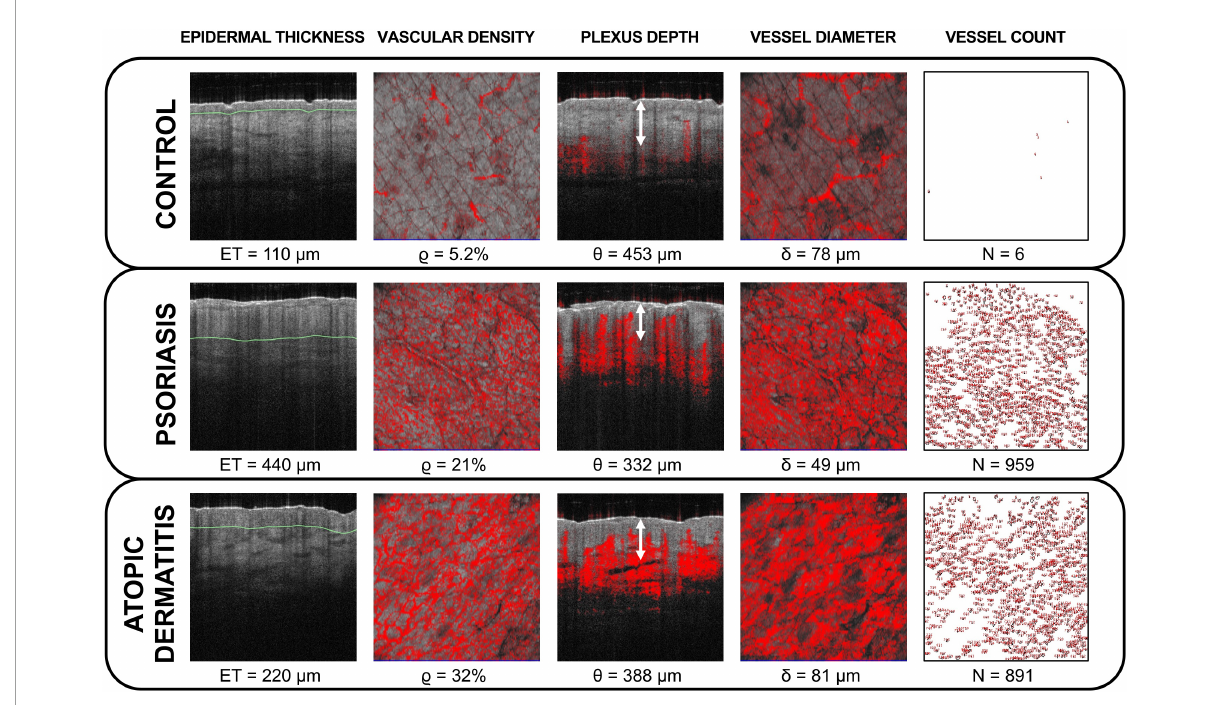
FIGURE2 Optical coherence tomography (OCT) imaging parameters for objective quantification of skin inflammation. Epidermal thickness ( ET ), vascular density (cid:37) , plexus depth θ , vessel diameter δ , and vessel count N were calculated in unaffected skin (control) and in target lesions (psoriasis and atopic dermatitis) at baseline. Lesional inflammatory skin exhibited increased epidermal thickness denoted by green lines and alterations in vasculature in comparison to control sites. The vascular density is exemplarily shown at 400 µ m depth and the vessel diameter is shown at 600 µ m depth. The plexus depth is indicated by white arrows. The vessel count was performed at 200 µ m depth.